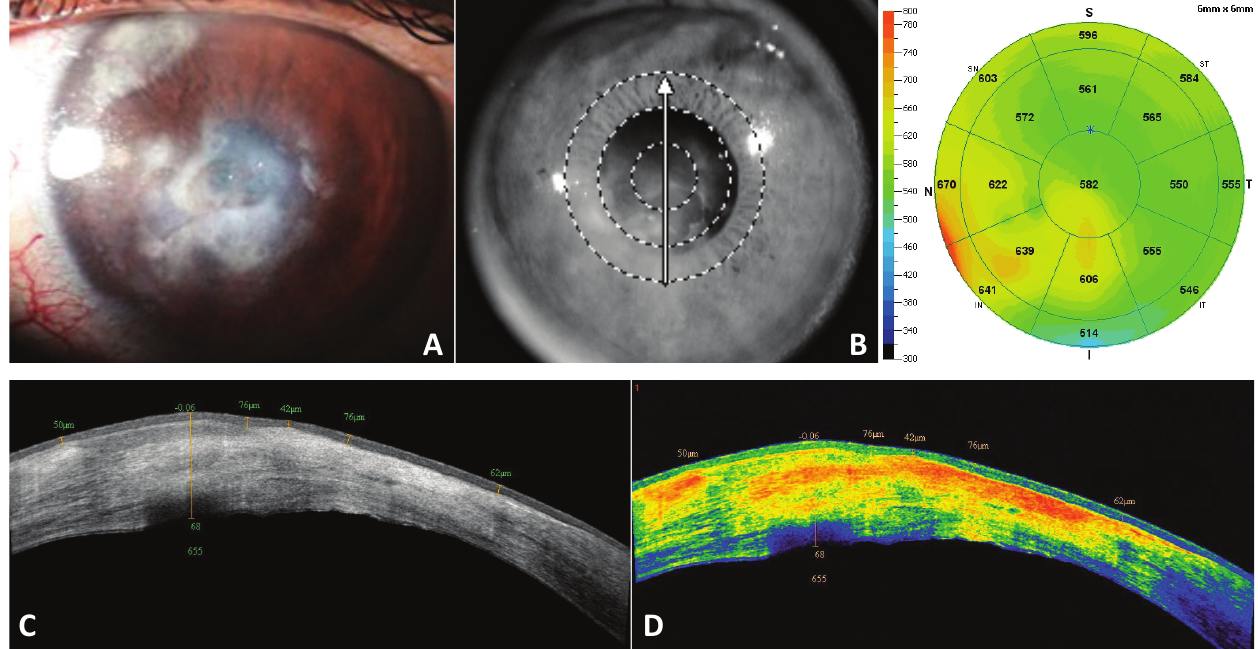
Figure 1. (A) Slit-lamp photograph of a cornea with active necrotizing HSK showing stromal inflammatory infiltration and edema. (B) SD-OCT pachymetry map showing a thickened cornea (max = 670 µm) corresponding to the area with stromal edema. (C) A cross-sectional view of the central lesion showing areas of epithelial thickening (max = 76 µm) over inflammatory infiltrates, corresponding to areas of hyperreflectivity, and hypodense areas, corresponding to stromal edema. (D) Color scale of the same lesion showing the inflammatory infiltrates and scarring in warm (orange to yellow) tones.